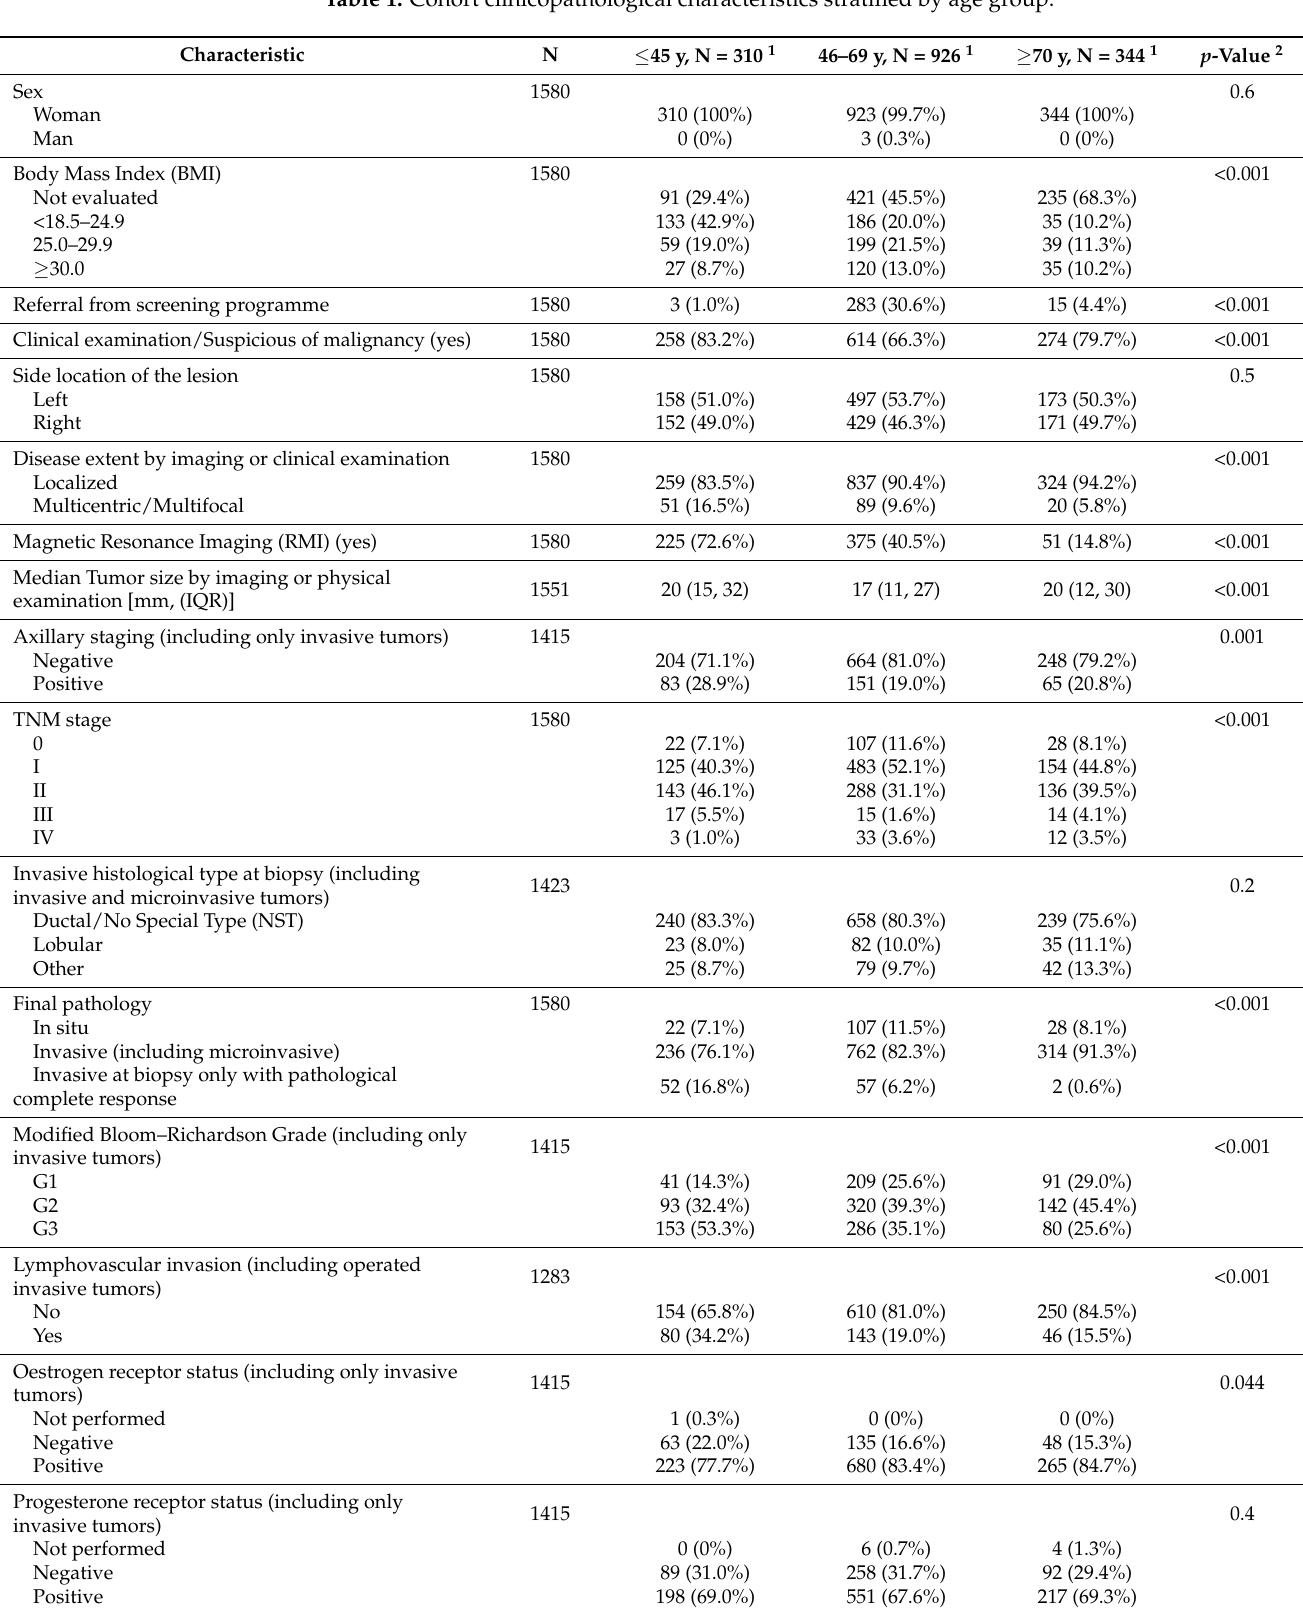
Table 1. Cohort clinicopathological characteristics stratified by age